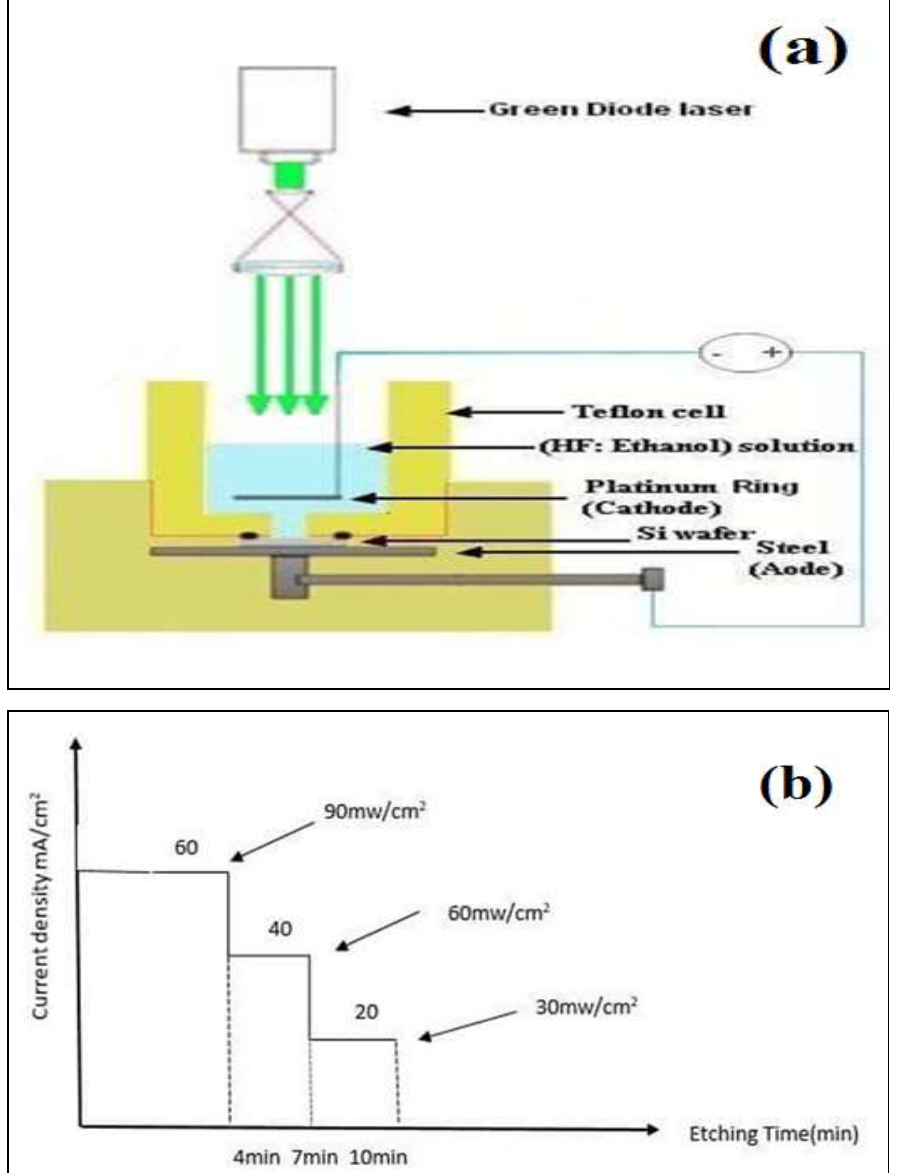
Figure 1: (a) schematic representation of photoelectrical etching, (b) graded laser irradiation